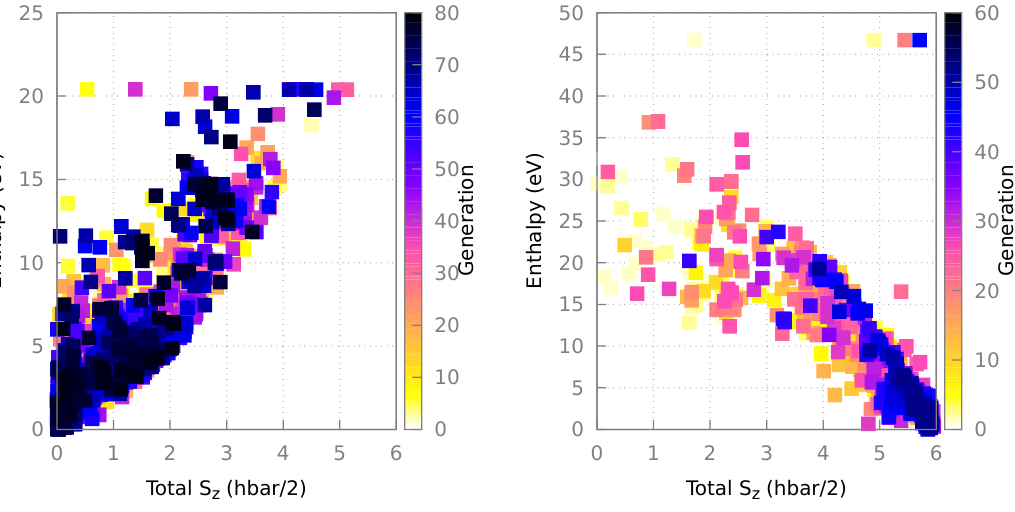
Figure 10. Convergence of the enthalpy and spin ( ∑ S z ) for each structure found by the GA relative to the ground state for the two parameterisations of the LJ + S potential: AFM ( left ) and FM ( right ). The color represents the generation in which that structure was